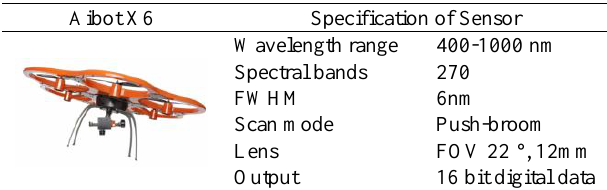
Table 1. Aibot X6 and specification of hyperspectral